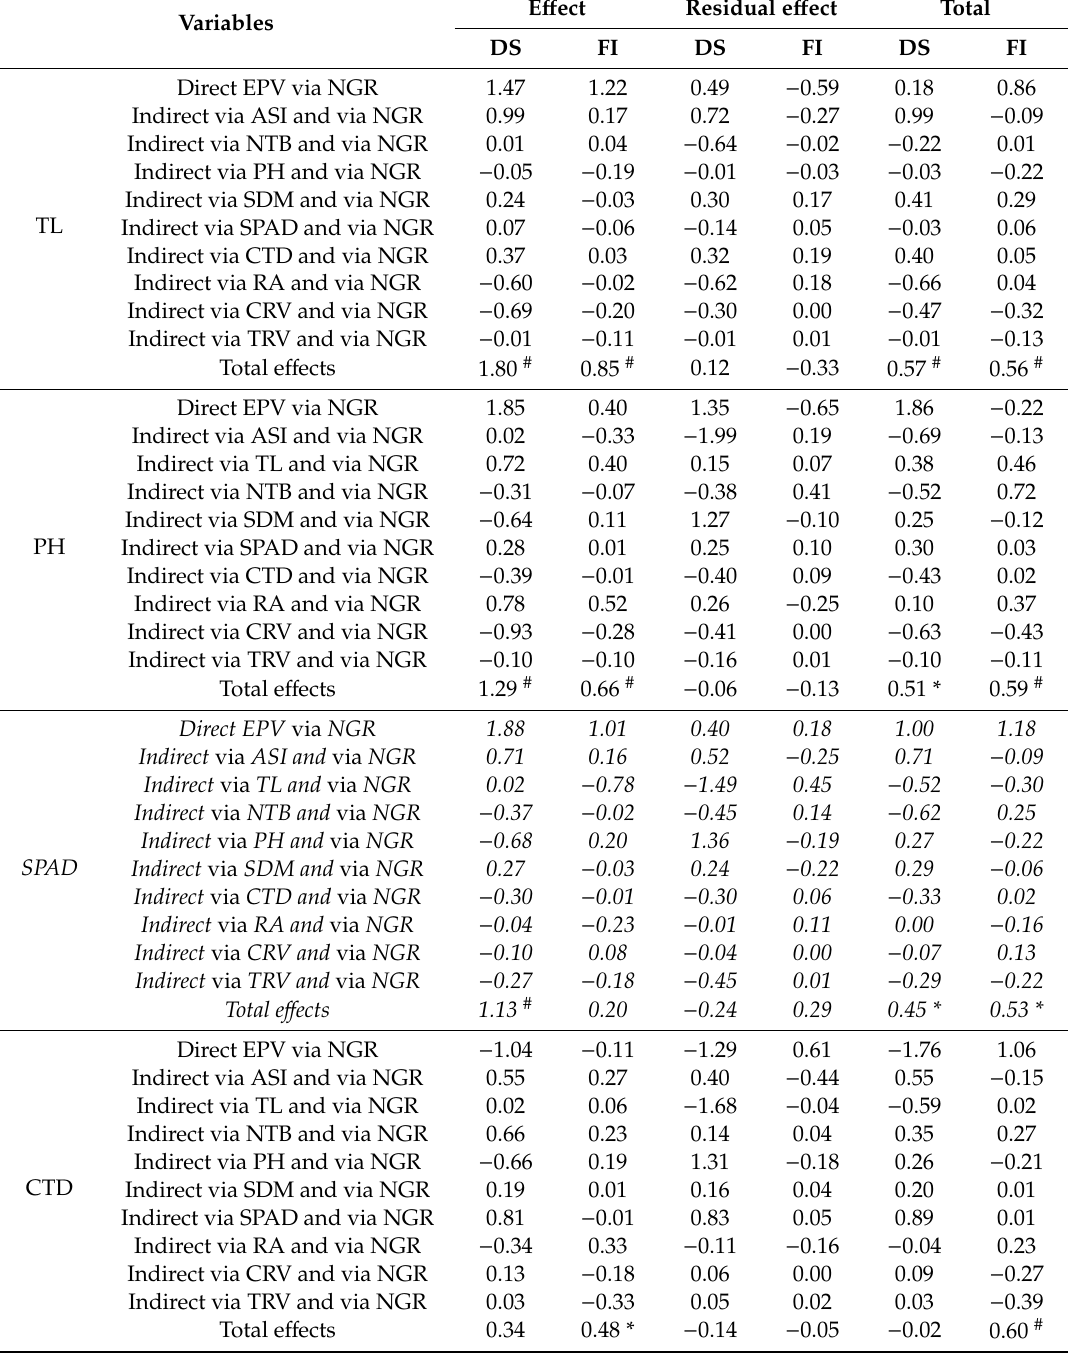
Table 4. Path analysis of the partitioning of genotypic correlations in components of direct and indirect e ff ects obtained between the main trait and the first-order agricultural traits and morphological, physiological, and second-order root traits evaluated in popcorn lines under FI and